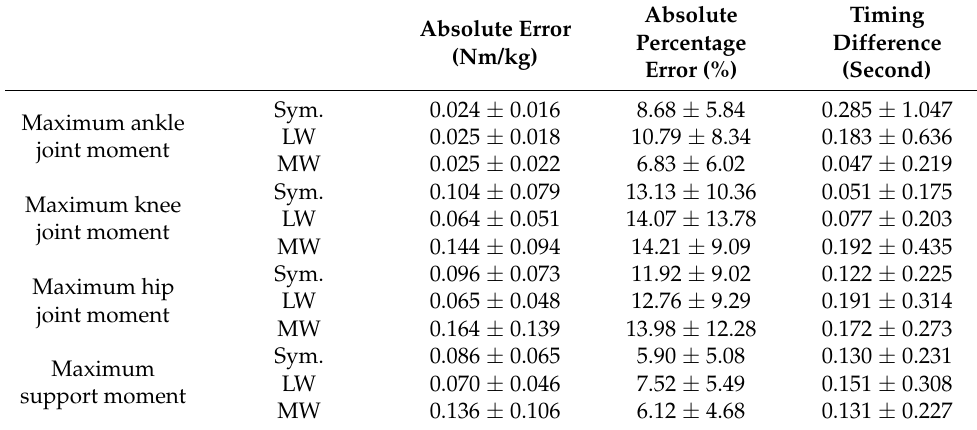
Table 4. Comparison of maximum joint moments and maximum support moment obtained from the proposed system and conventional system with the motion capture system.